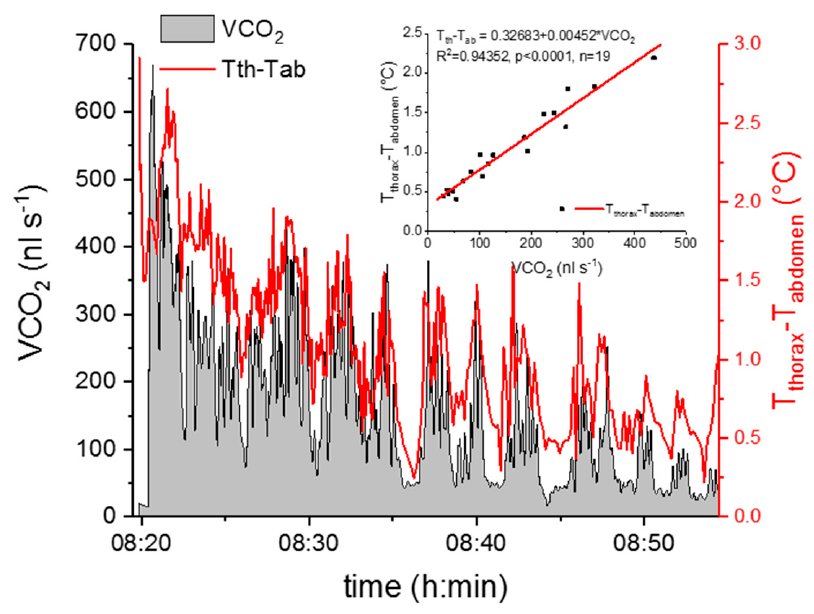
Figure 5. The CO 2 production rate and the thorax temperature excess (T thorax –T abdomen ) of an active wasp ( Polistes biglumis ) in dependence on time. The insert shows the correlation between the CO 2 production rate and the thorax temperature excess.